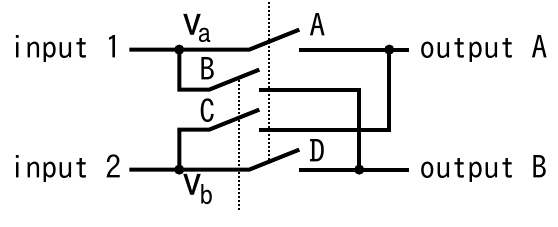
Figure 5. Schematic diagram of circuit exchange